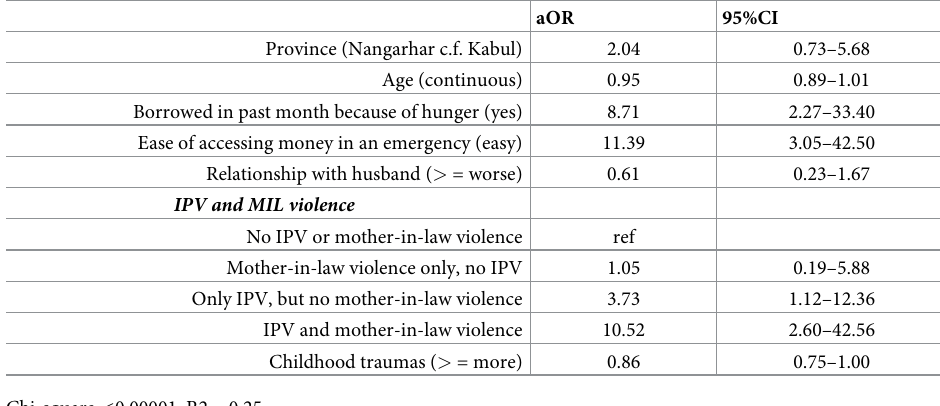
Table 3. Factors associated with married women reporting ‘honour killing’ in Afghanistan (n = 899).